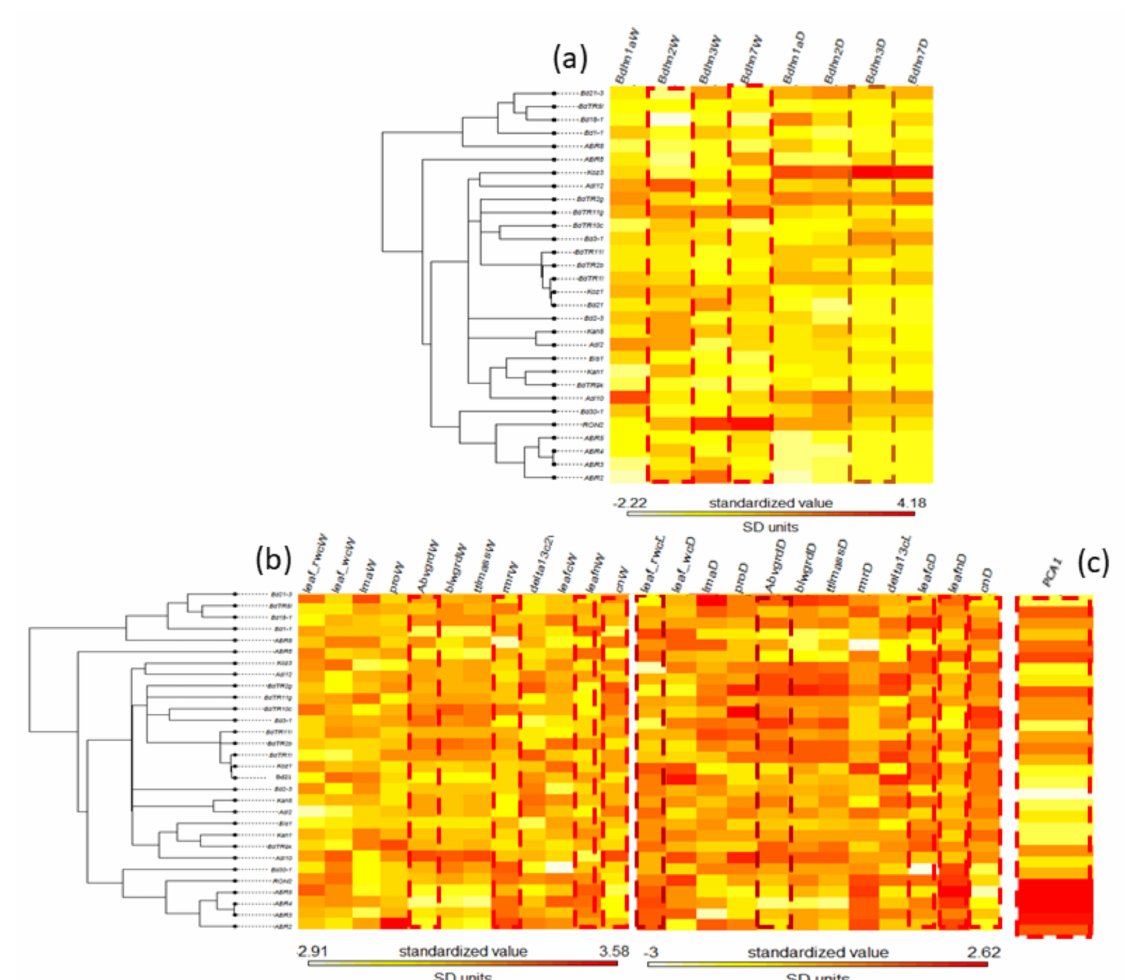
Figure 6. Maximum likelihood B. distachyon Bdhn tree cladogram showing the relationships of 30 ecotypes. Phyloheatmaps of normalized values for different sets of variables: ( a ) dehydrin ( Bdhn 1, Bdhn 2, Bdhn 3, Bdhn 7) gene expression values under watered (W) and drought (D) conditions; ( b ) drought-response phenotypic traits (leaf_rwc: relative water content in leaf; leaf_wc: water content in leaf; lma: leaf mass per area; pro: leaf proline content; abvgrd: above ground biomass; blwgrd: below ground biomass; ttlmass: total plant mass; rmr: root mass ratio; delta13c: carbon isotope, a proxy for lifetime integrated WUE; leafc: leaf carbon content; leafn: leaf nitrogen content; cn: leaf carbon/nitrogen ratio) values under watered (W) and drought (D) conditions; ( c ) climate niche PC1 values. Traits showing significant phylogenetic signal are highlighted with dotted lines (see Supplementary Table S13b). Watered (W): soil irrigated to field capacity every second day; Drought (D): soil water content reduced by ~5% each day (during the 10 days